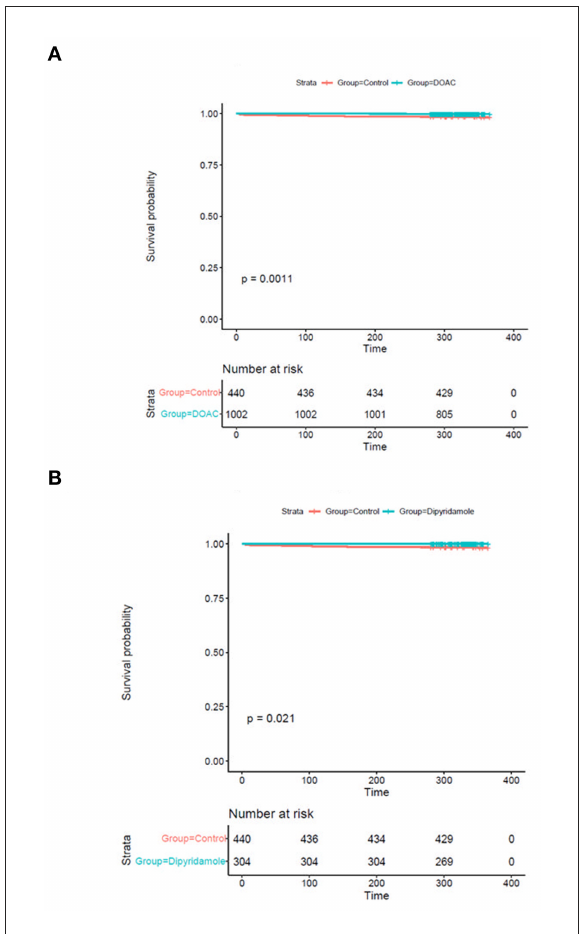
FIGURE4 Kaplan-Meier plots of cardiovascular survival probability (A) cardiovascular mortality rates of controls vs. patients treated with DOAC, (B) cardiovascular mortality rates of controls vs. patients treated with